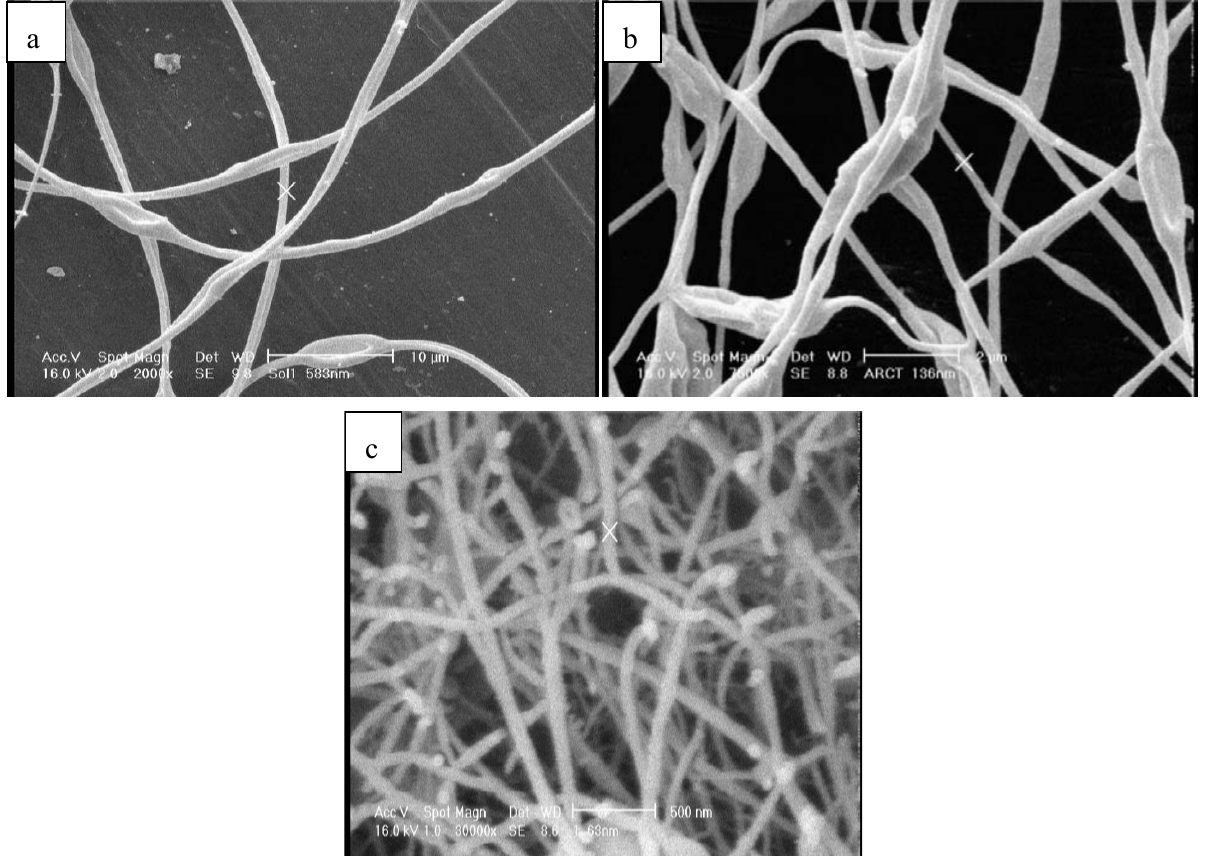
Figure 1. Scanning electron microscope (SEM) images of ( a ) as spun Polyvinyl pyrrolidone (PVP)/Pd/ peroxopolytungstic acid (P-PTA) fiber; ( b ) WO sintering at 500 °C for 1 h; ( c ) sintered sample with high density of fibers. a